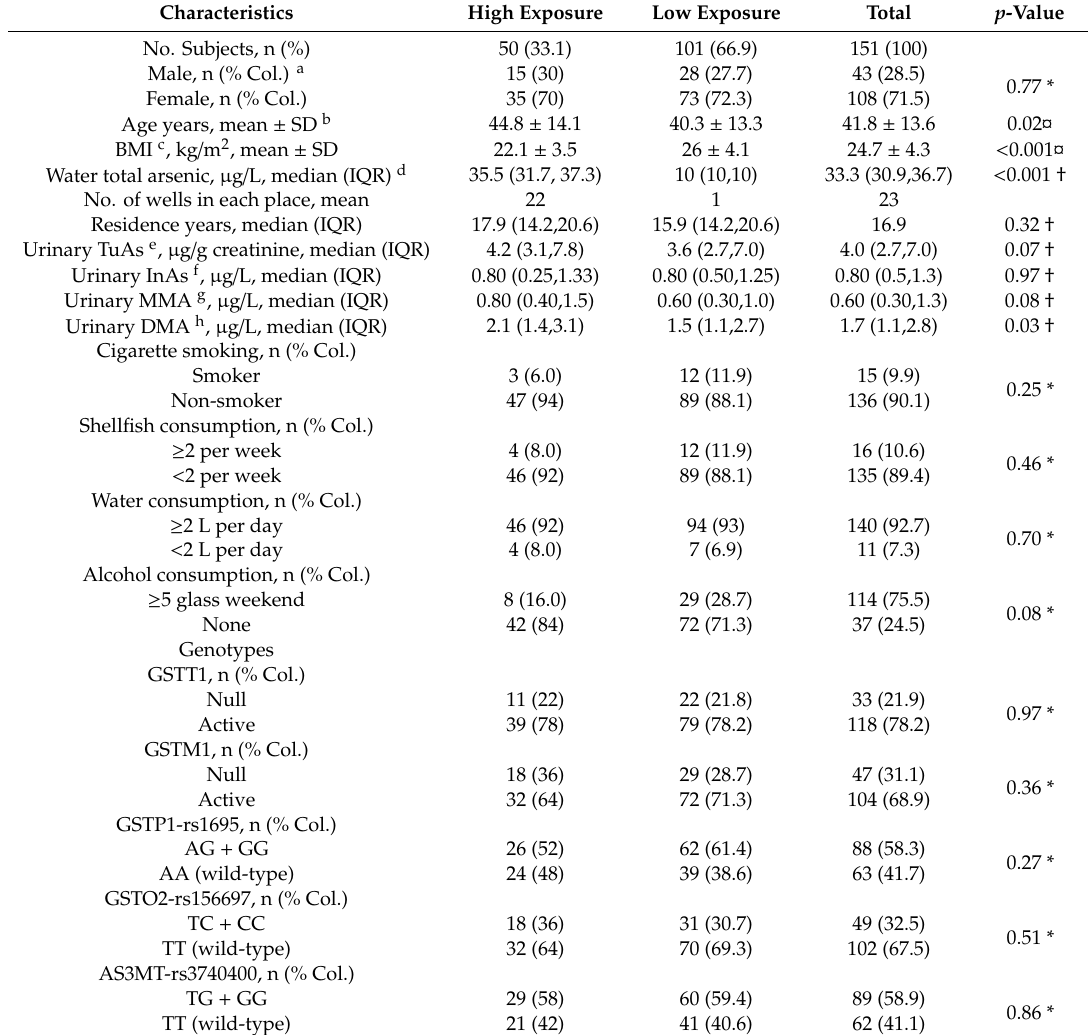
Table 1. General characteristics of the study